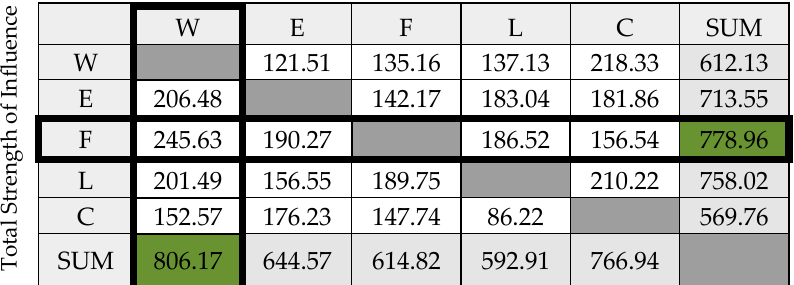
Figure 6. Cross-interlinkage matrix of five nexus components and their interactions for Greece. The total strength of interlinkage from a nexus component on all other nexus components is shown by the row-sum and the column-sum shows how much a nexus component is influenced by all other nexus components in total. Highest row- and column-sums are marked in green. W = Water; E = Energy; F = Food; L = Land Use; C = Climate.